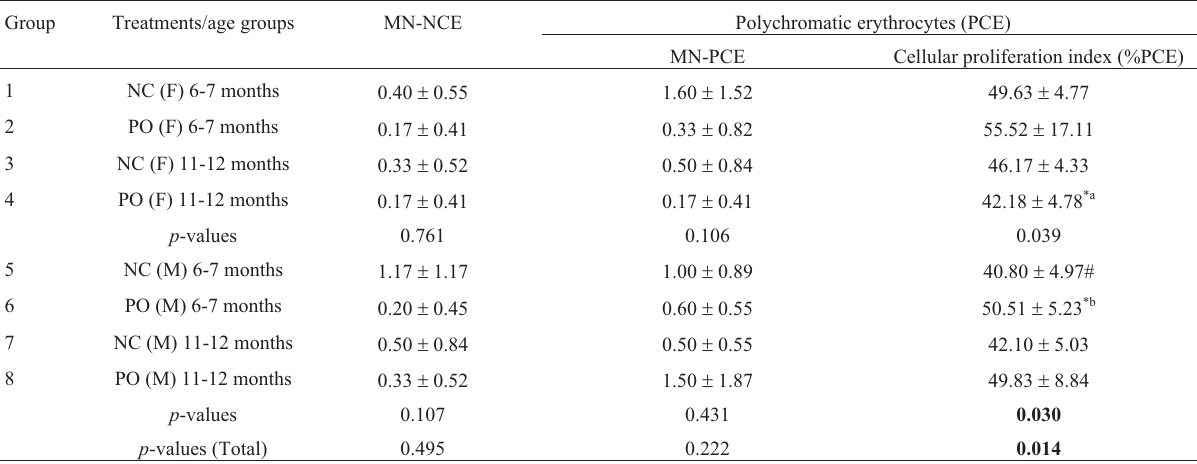
Table 7 - Frequencies of micronucleus (MN) evaluation and polychromatic erythrocytes (% PCE) of bone marrow cells of elderly female (F) and male (M) Swiss albino mice after treatment with pequi oil (30 mg/animal/day) administered orally for 15 consecutive days. Negative controls (NC) received filtered water administered in the same